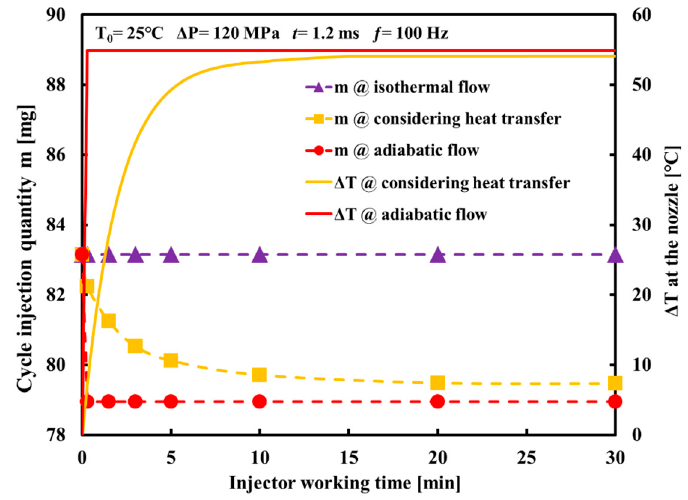
Figure 11. The calculation results of cycle injection quantity against the injector working time under different conditions.